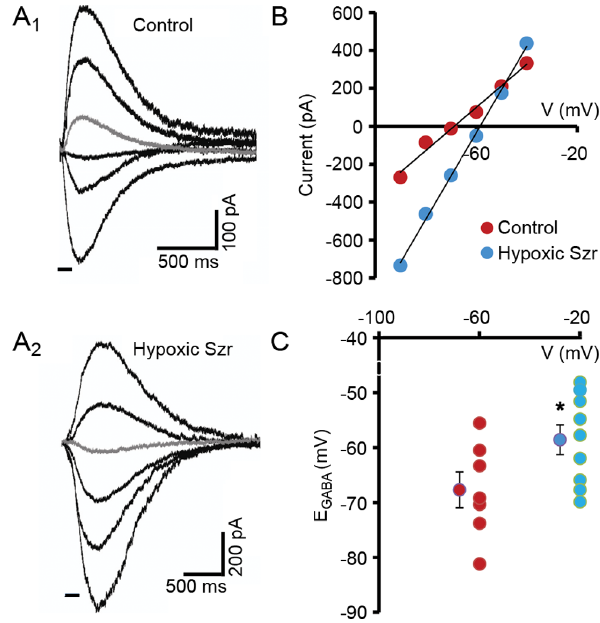
Figure 6. Hypoxic seizures induce a positive shift in E GABA in hippocampal CA1 pyramidal neurons. Representative recordings of GABA-evoked currents in CA1 neurons from normoxic control hippocampal slices (A1) versus slices removed at 24 hr post-hypoxic seizures in vivo at P10 (A2). (B) Current–voltage curves for the recordings shown in A1 and 2. The data points were fitted with a straight line. (C) Summary of the reversal potential of the GABA-evoked currents in CA1 pyramidal neurons in slices removed after hypoxic seizures (n=9, 2 58.58 6 2.72 mV) compared with control slices (n=7, 2 67.70 6 3.26 mV). Error bars indicate SEM. * p ,